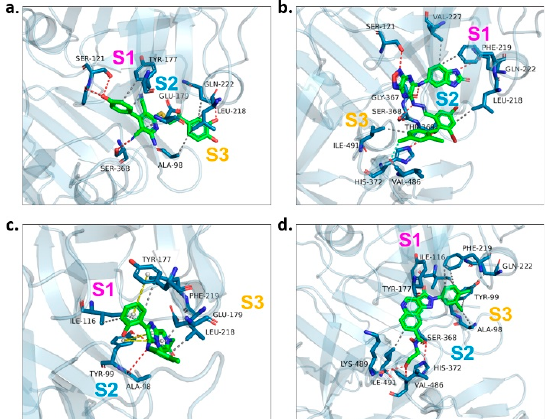
Figure 5. Proteinligand interactions of candidate compounds with Pf PMV. ( a – d ) illustrate the binding of residues with compounds 17 , 47 , 62 and 147 . Candidate compounds were shown in green color. S1, S2 and S3 represent three subpockets. Dashed line in red indicates H-bonds interactions,